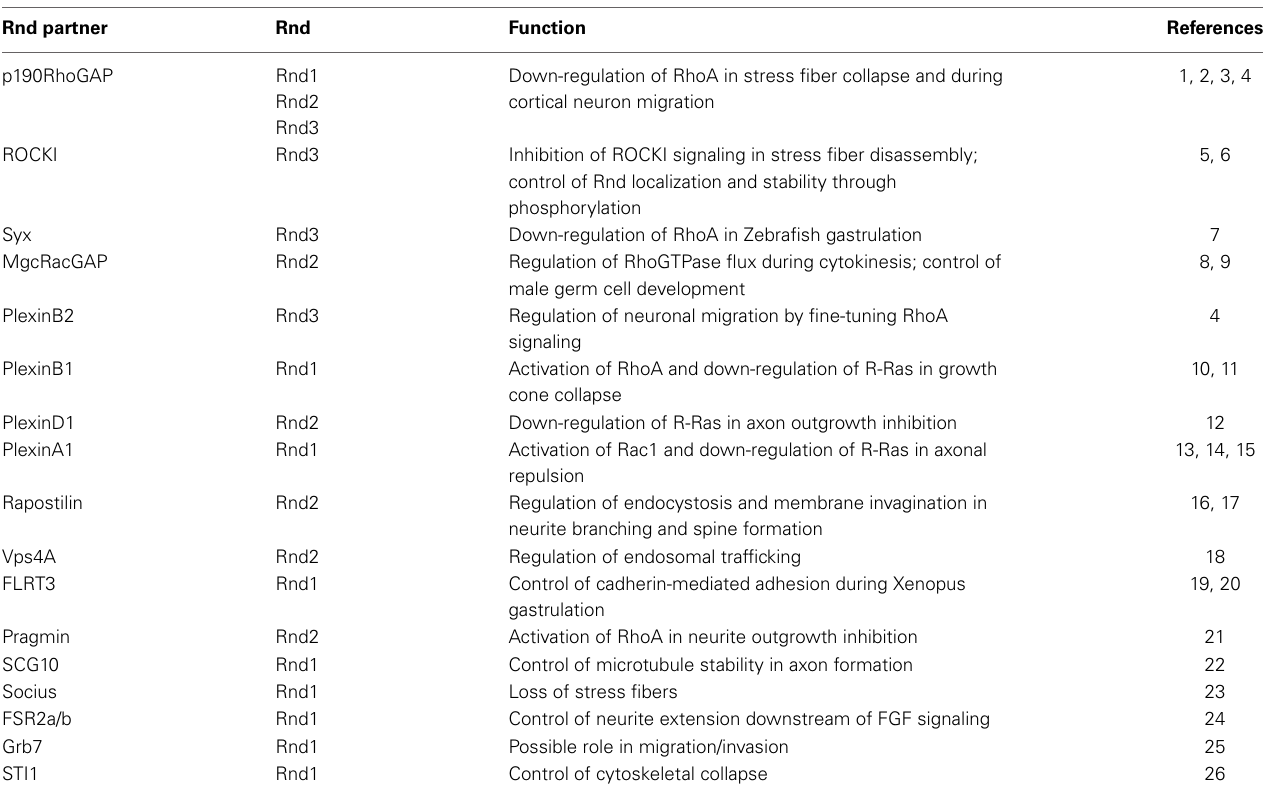
Table 3 | Rnd interacting partners and their functions. Rnd